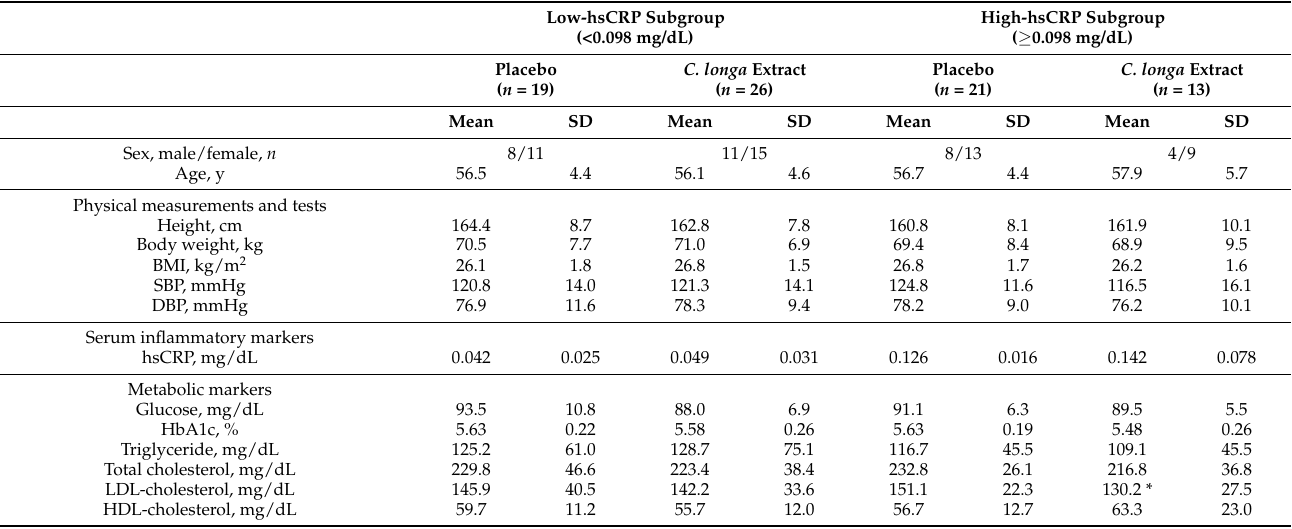
Table 3. Baseline characteristics of the participants stratified by serum hsCRP protein levels in study 2 1